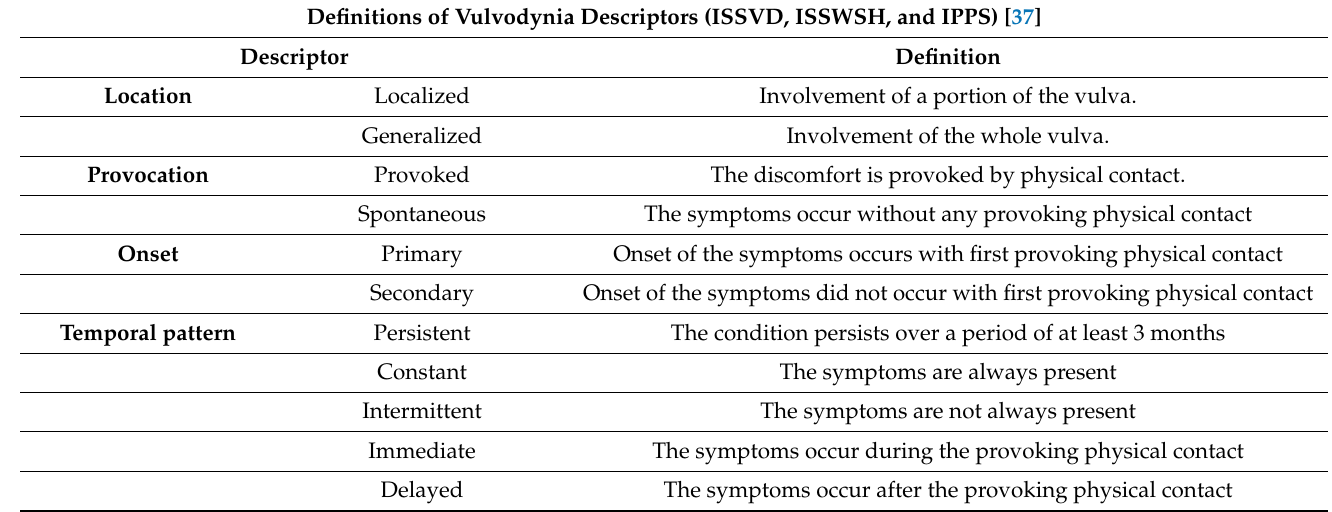
Table 3. Vulvodynia Descriptors (ISSVD, ISSWSH, and IPPS) [37].